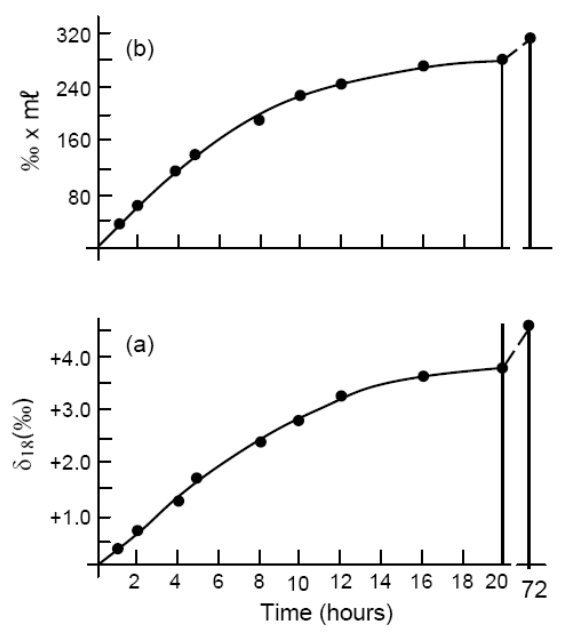
Fig. 14 Exiting of isotopes accumulated in the membrane during the previous experiment (fig. 13) to water in the upper cell. a Change of the δ b Quantity of heavy isotopes, 18 O, exiting from the